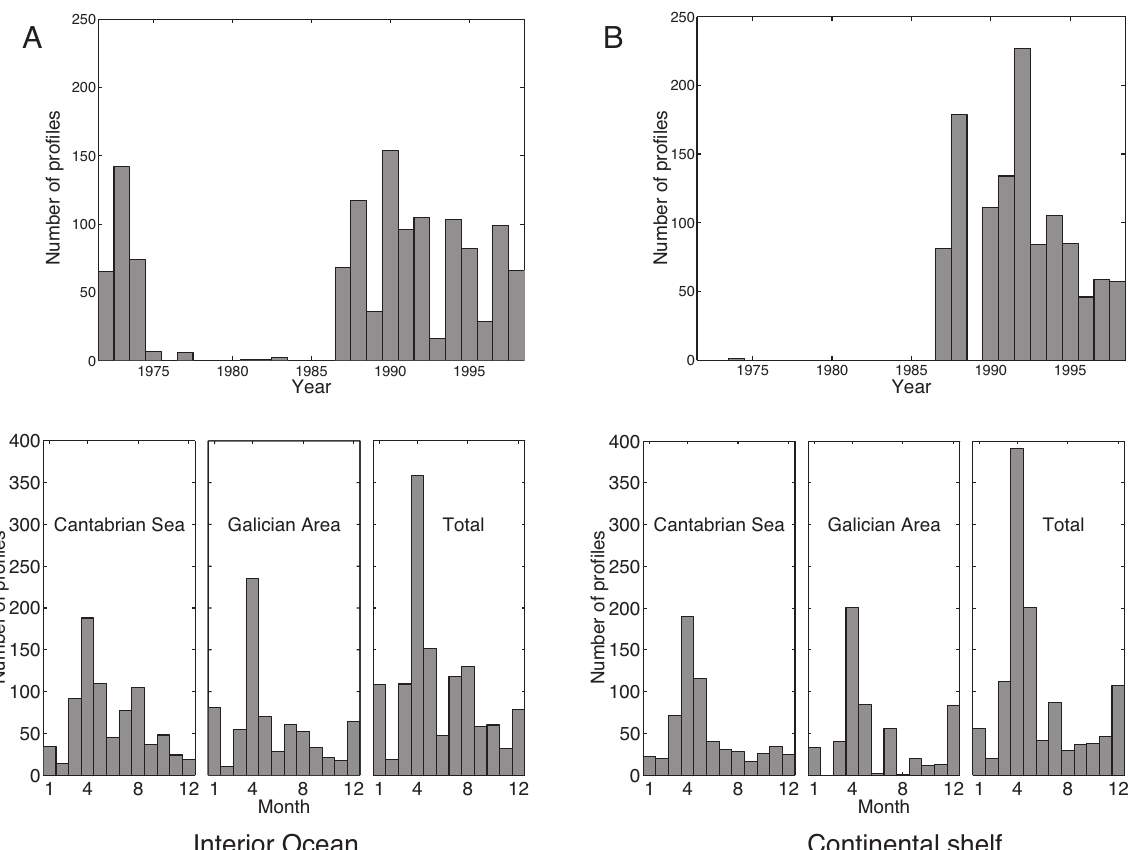
Fig . 4. – Yearly (upper) and monthly (lower) distribution of CTD profiles available for the interior ocean (A) and the continental shelf region (B). Monthly distributions are given for the Cantabrian Sea (left), Galician Area (middle), and total (right). See also Table